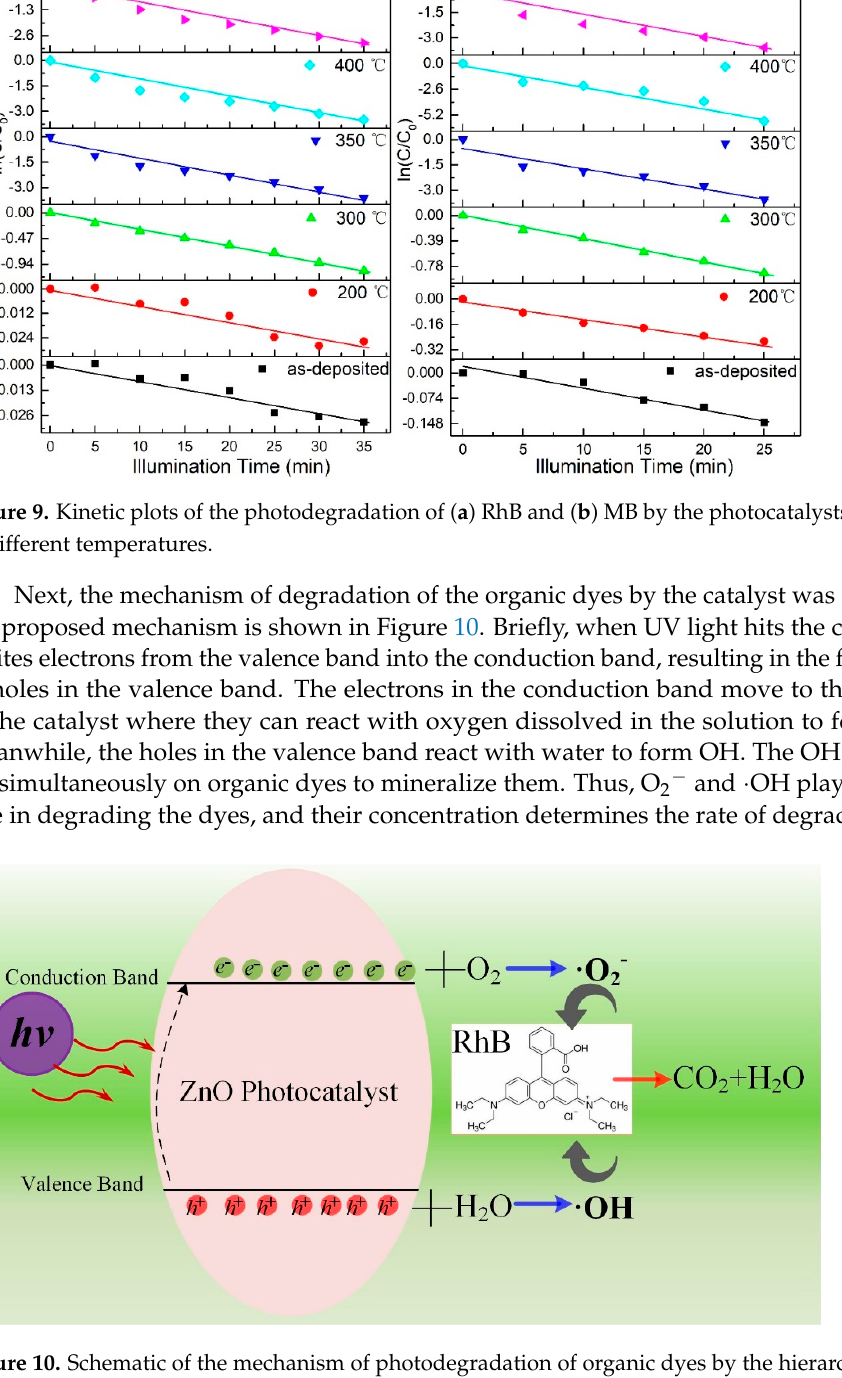
Figure 8. UV-vis absorbance spectra of MB solutions treated with the photocatalyst prepared at ( a ) RT and annealed at different temperatures for different periods: ( b ) 200, ( c ) 300, ( d ) 350, ( e ) 400, ( f ) 450, and ( g ) 500 °C. ( h ) Degree of photodegradation of MB annealed at different temperatures.